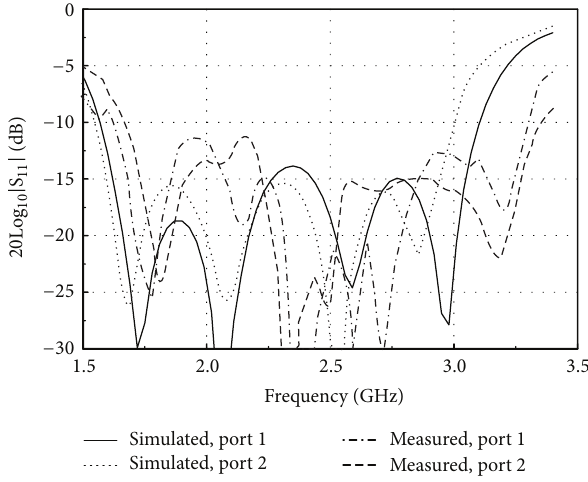
Figure 6: Simulated and measured |𝑆 11 | .